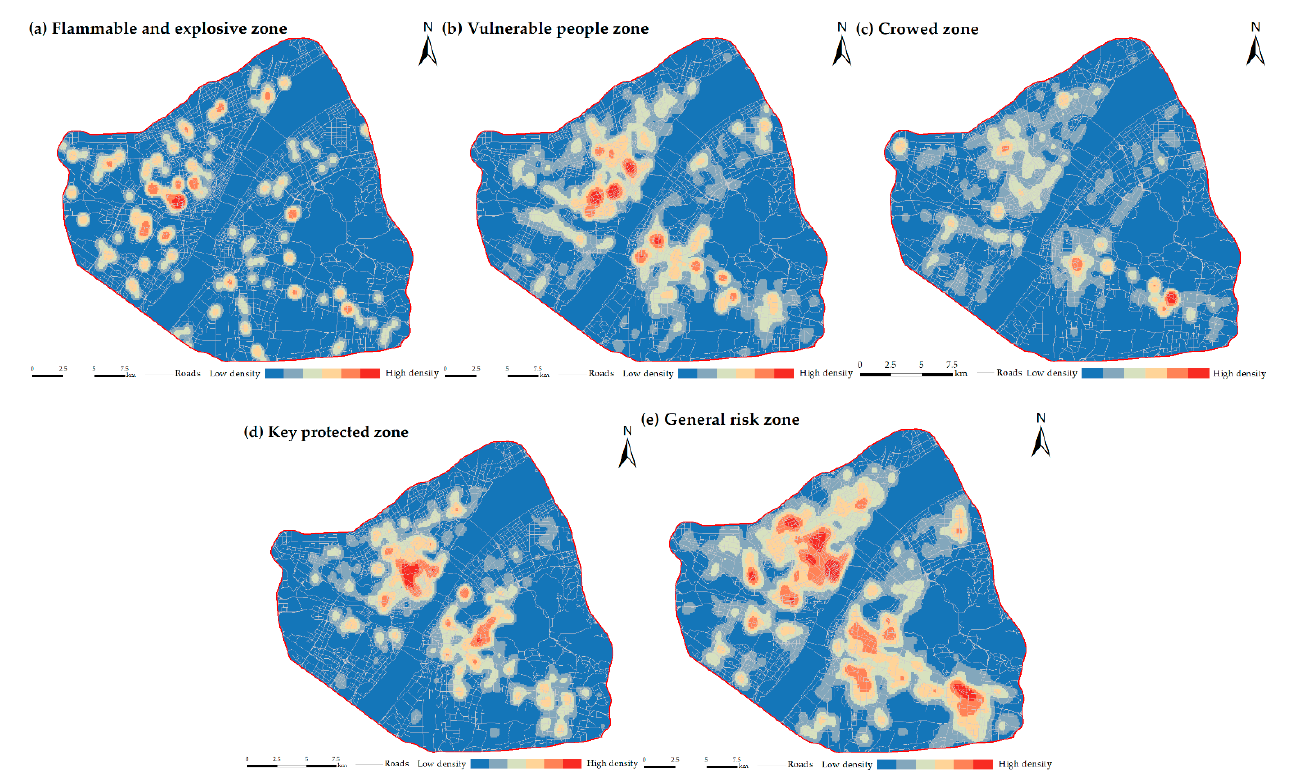
Figure 6. Kernel density distribution of various fire-risk zones (Natural Breaks method). Table 6. Decision matrix of various fire-risk zones. (Z1 is general risk zone; Z2 is flammable